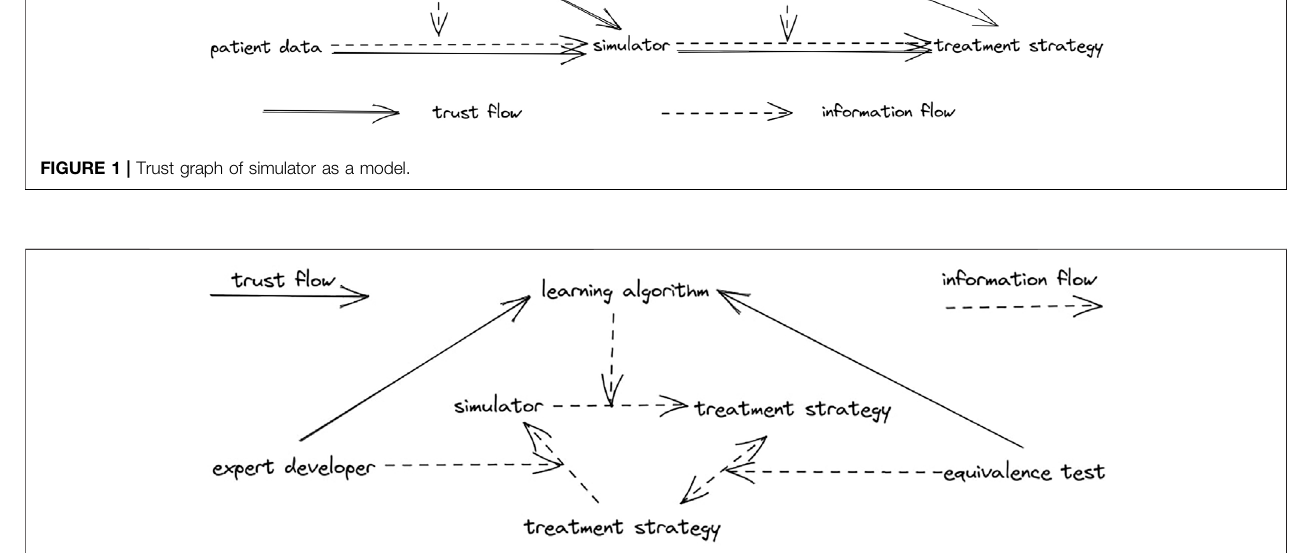
FIGURE 2 | Trust graph of simulator as a